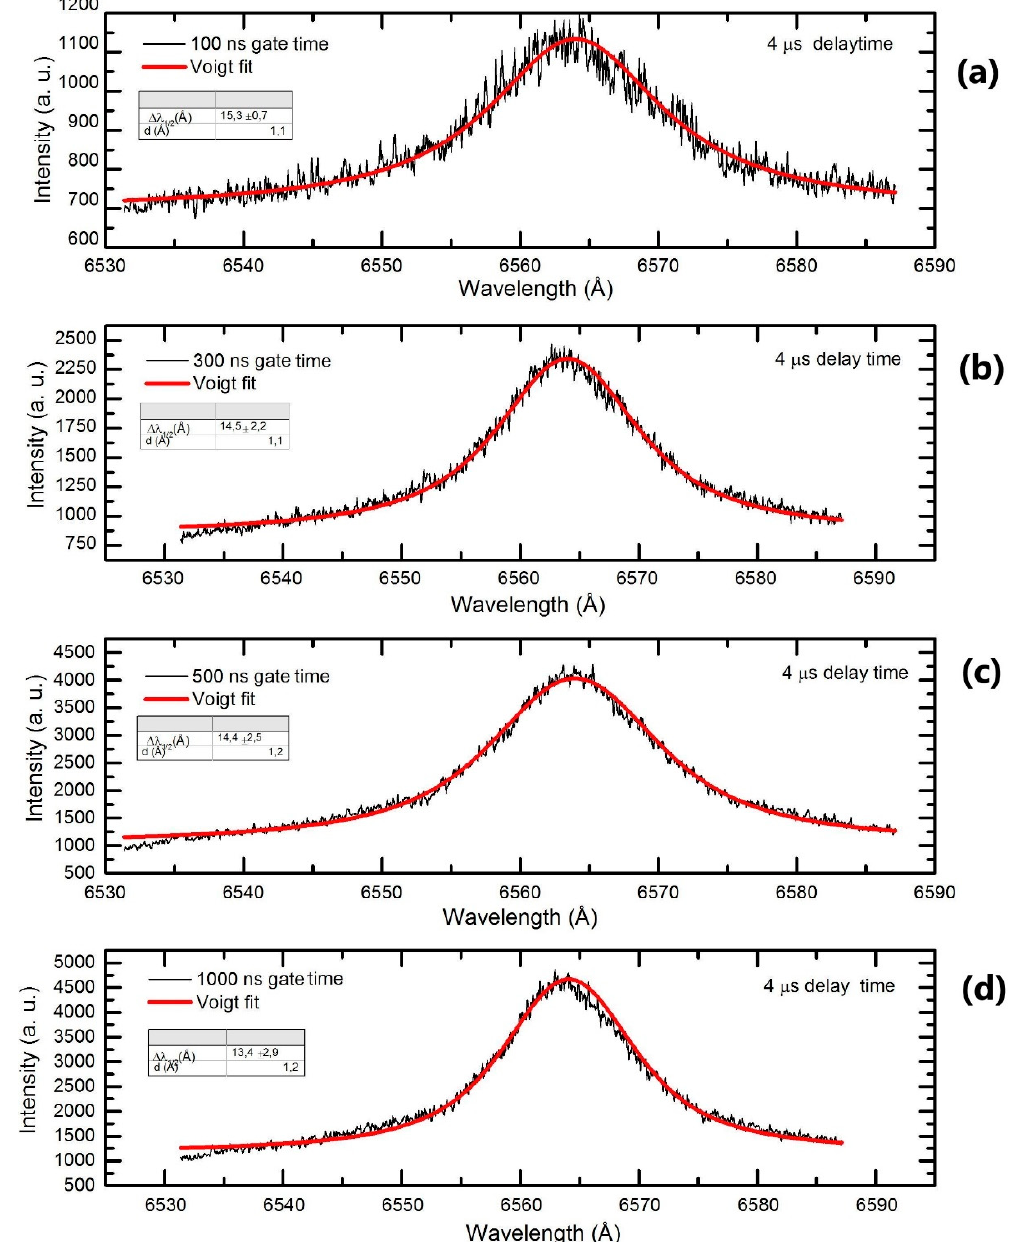
Figure 5. Fitting from a Voigt profile to experimental line emissions of the plasma with gate times of ( a ) 100 ns, ( b ) 300 ns, ( c ) 500 ns, and ( d ) 1000 ns at 4 µ s delay time with a wavelength range from 6530 to 6590 Å. The corresponding Stark broadening and red shift appear in the left side of every spectrum. As can be observed, the best line profiles are at 300 and 500 ns. At 100 ns and 1000 ns there are slight asymmetries that are attributed to the fact that signal integration times are not adequate. At 100 ns, the signal integration time is too short and at 1000 ns, it is too long. It is also observed that despite these disadvantages for the 100 ns and 1000 ns gate times, the Stark widths and shifts obtained are the same in all gates within the experimental error